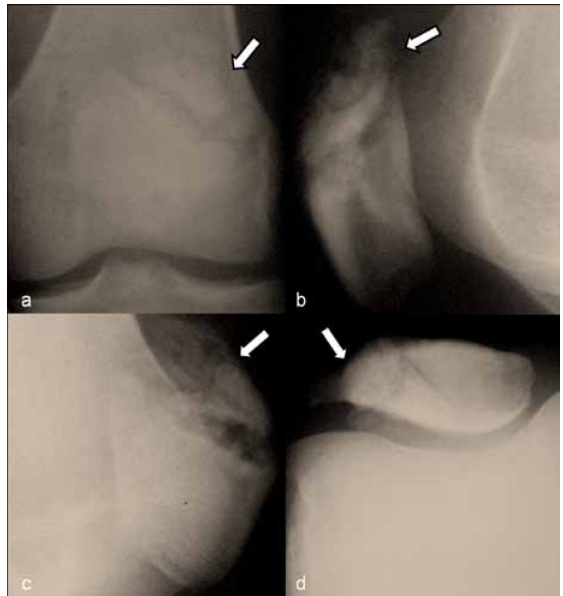
Figure 3. The transverse (a), (b), (c) and the longitudinal oblique (d) ultrasound images demonstrate fragmentation of the superolateral-lateral patellar pole (in dashed line) and hypoechogenicity of the vastus lateralis insertional tendon fibers